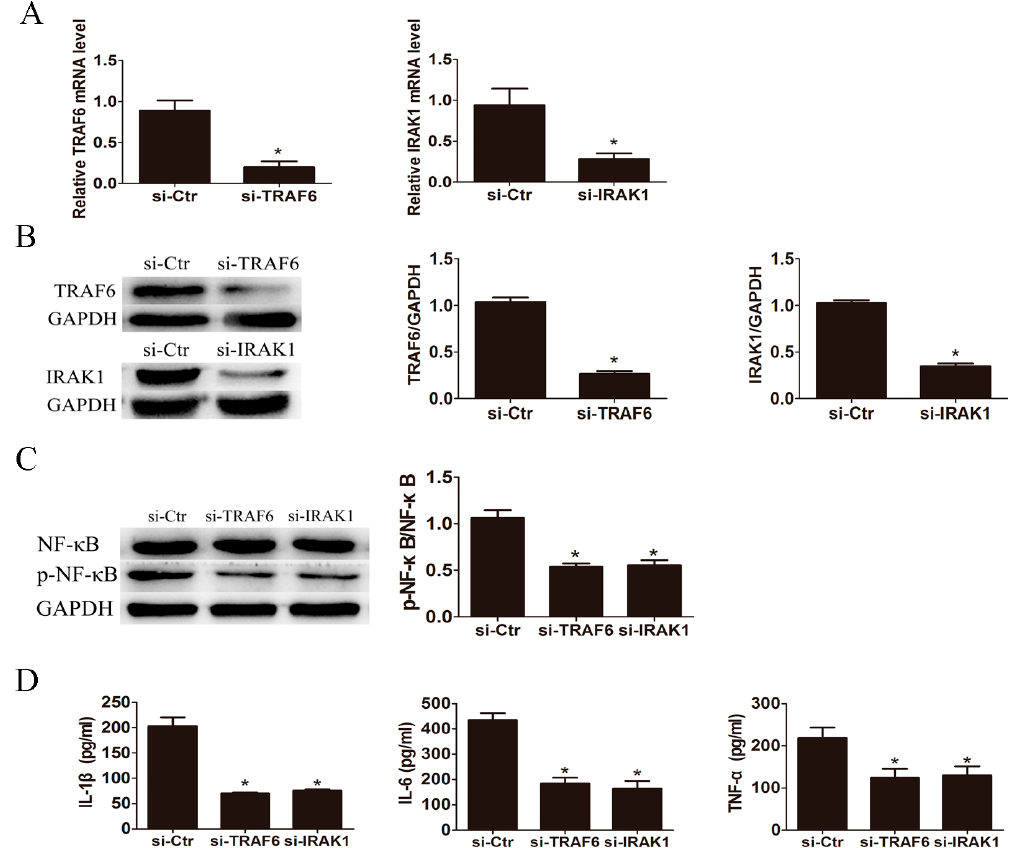
Figure 4. Knockdown of TRAF6 and IRAK1 suppressed the production of IL-1 β , IL-6 and TNF- α in LX2 cells. TRAF6 siRNA (si-TRAF6) and IRAK1 siRNA (si-IRAK1) efficiently decreased the mRNA ( A ) and protein expression ( B ) of TRAF6 and IRAK1, respectively. Both TRAF6 and IRAK1 siRNA significantly attenuated the phosphorylation of NF- κ B ( C ) and suppressed the production of IL-1 β , IL-6 and TNF- α in LX2 cells after treatment with 500 ng/mL of LPS for 24 h ( D ). * p < 0.05 vs. control group (si-Ctr).